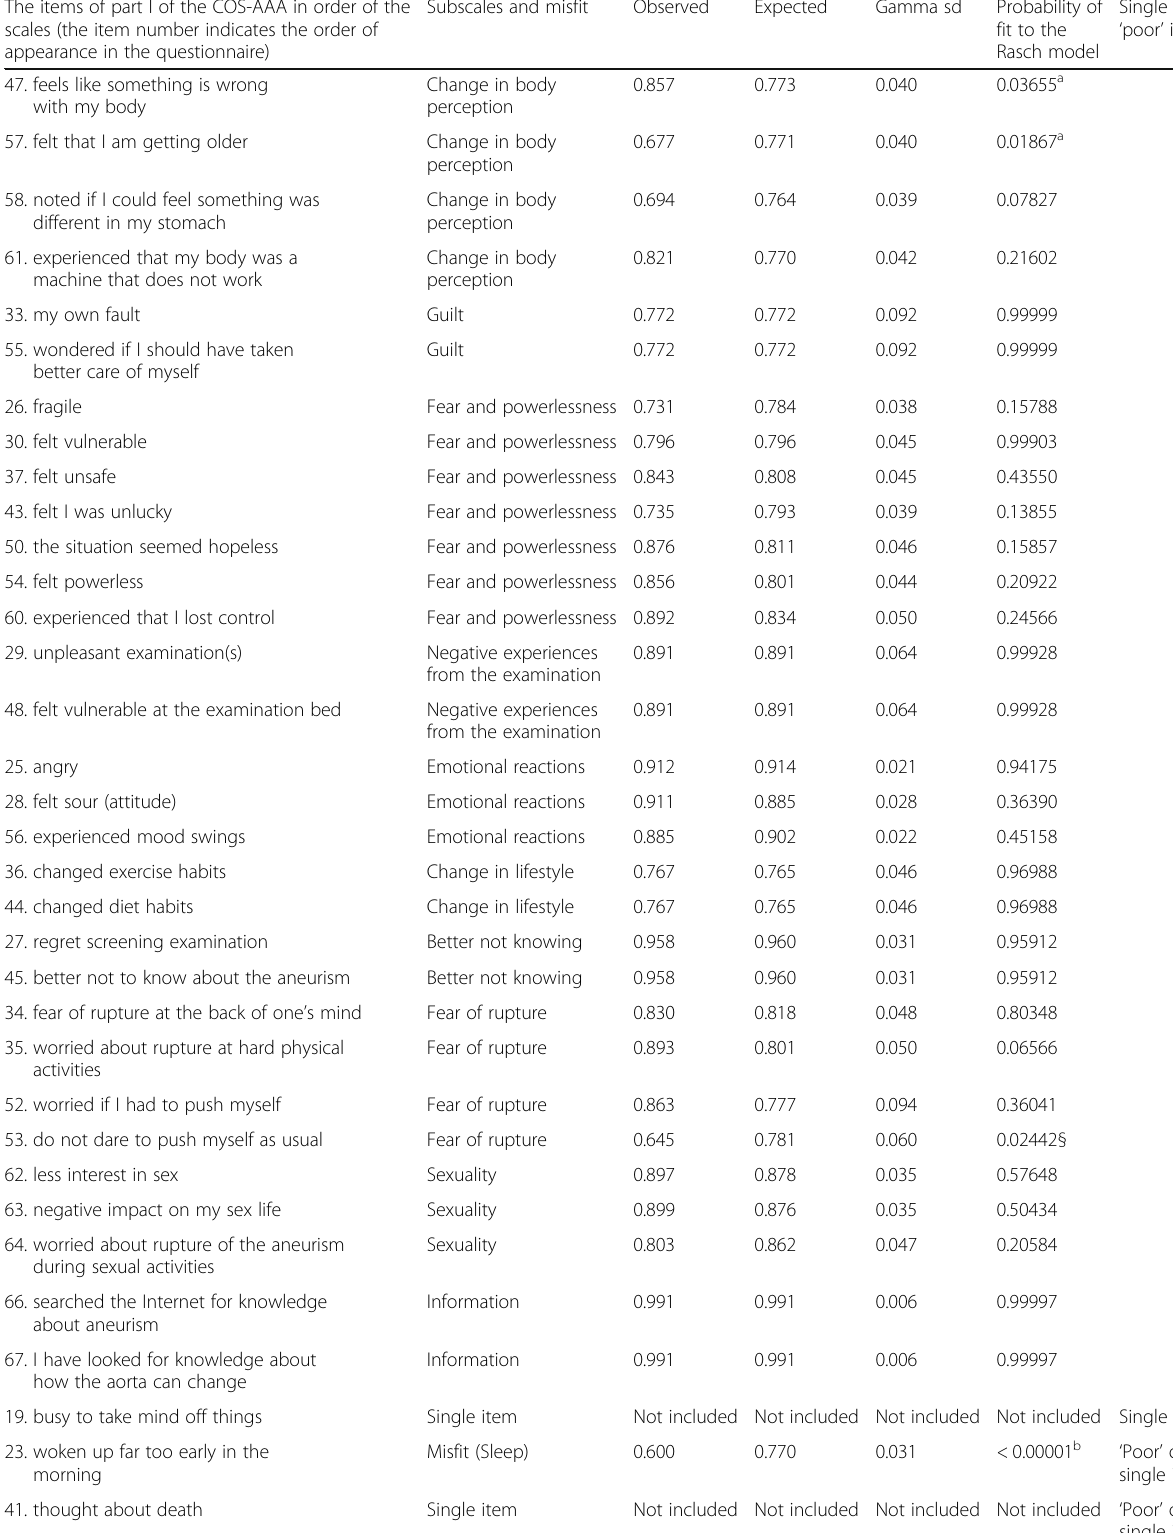
Table 3 Summary of result from the psychometric analyses of part 1 of the COS-AAA (Continued) The items of part I of the COS-AAA in order of the scales (the item number indicates the order of appearance in the